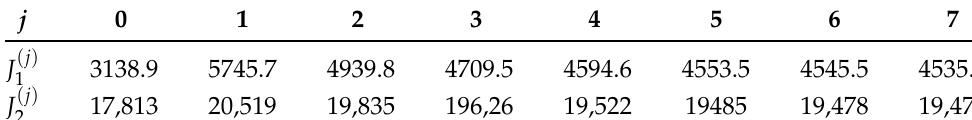
Table 1. System performance index values J